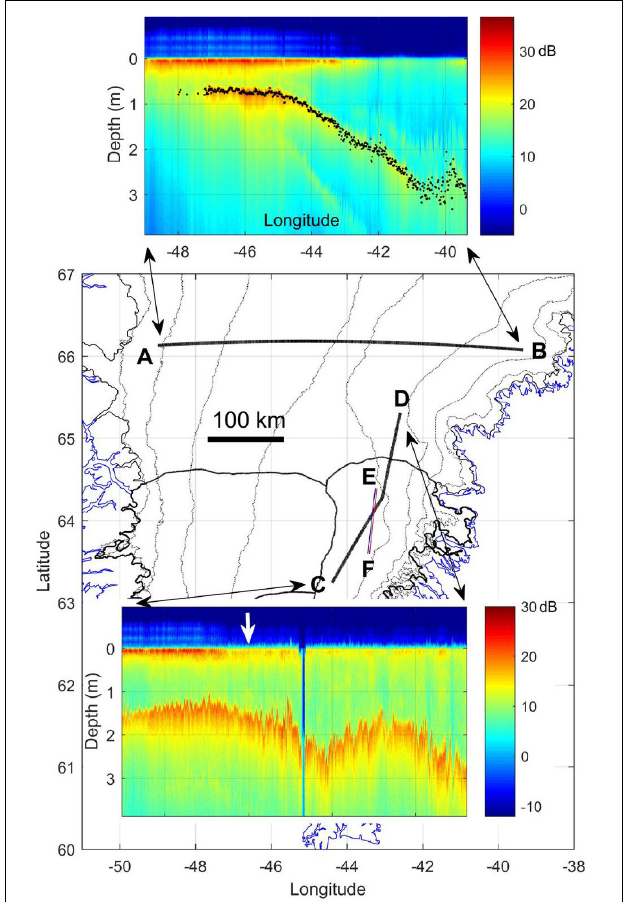
FIGURE 8 | The positions of two airborne IceBridge Ku-band altimeter flight line segments from April 13, 2015 are marked as AB and CD. The two insert images illustrate the airborne Ku-band altimeter results in which the waveforms have been aligned, smoothed along-track, and the return power in dB represented in color. The white arrow in the lower insert image indicates the position of the airborne Ku-band waveform in Figure 7 . The black dots in the upper insert image show the estimated depth of the last-summer melt layer in meters and the strong west-east gradient in snow accumulation. The two closely spaced lines at EF are the positions of two CryoSat passes from April 17, 2015 and July 10, 2015. Part of the boundaries of basins 6.1 and 4.3 are shown on either side of the central ice divide. The limit of the ice sheet is marked in black and the coastline in blue.